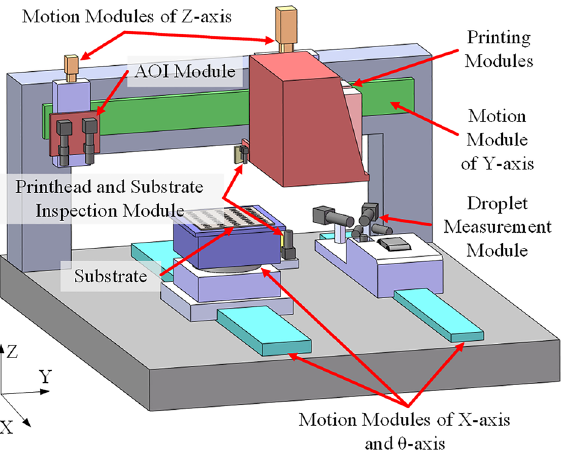
Figure 4. Simplified diagram of the printing